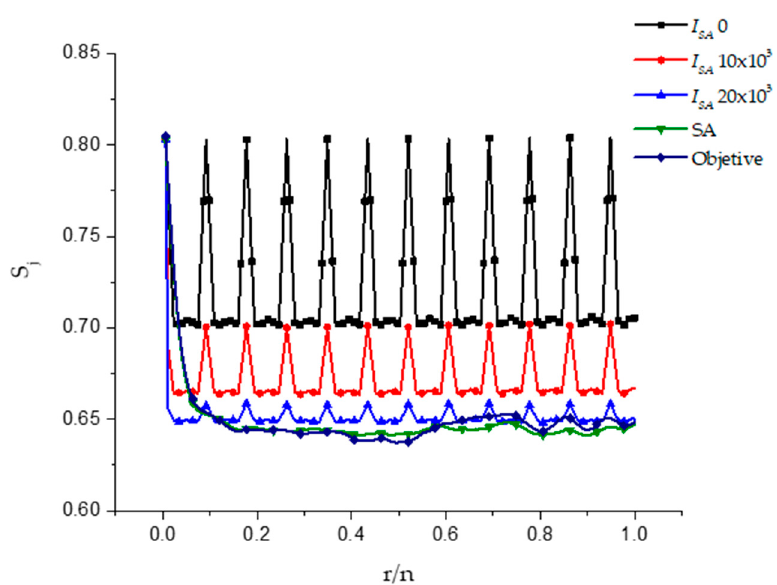
Figure 5. Correlation functions of Sj during the reconstruction process of S800X.